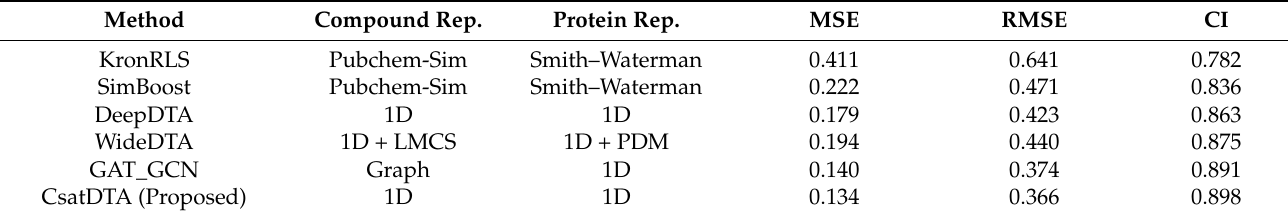
Table 2. Performance on the KiBA dataset in terms of prediction.